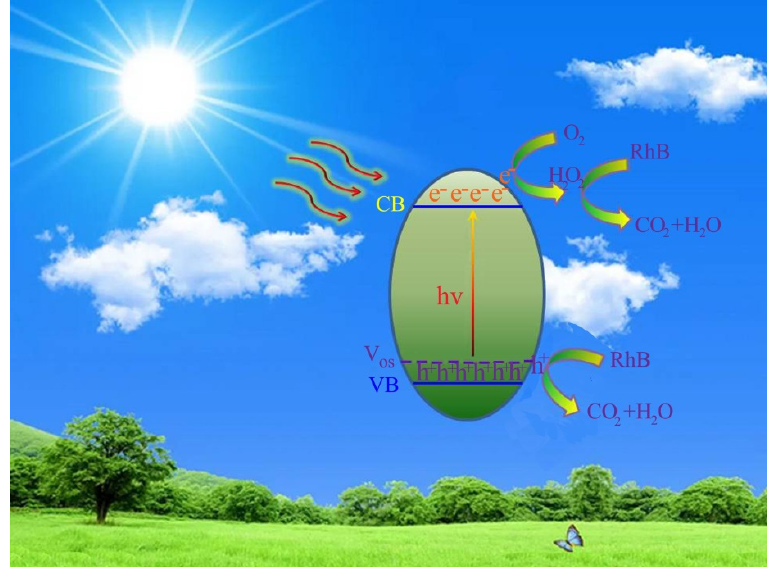
Figure 9. A schematic diagram of the proposed photodegradation mechanism over the SnO 2 − x system under visible-light illumination.